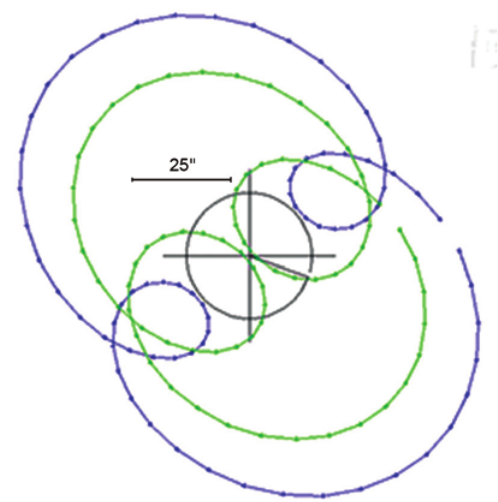
Fig. 7. Reference ellipsoid’s normal (blue) and plumb line direction (green) trajectories in rotating coordinate system and difference between them (black), representing their relative